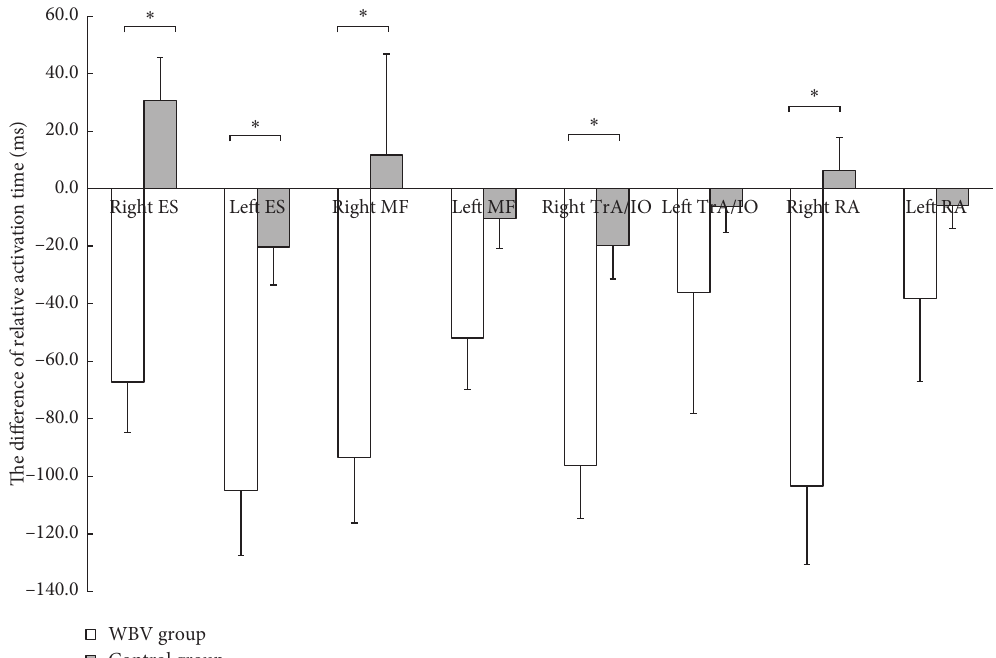
Figure 4: Between-group comparison of variation in relative activation time on shoulder abduction. Variation � post-test–pre-test, a negative value indicated that the intervention shortened the relative activation time, and vice versa. WBV, whole-body vibration; ES, erector spinae; MF, multifidus; TrA/IO, transversus abdominus/internal oblique; RA, rectus abdominis. The independent-samples t -test was used to compare the variation. ∗ Significant at P < 0 . 05.